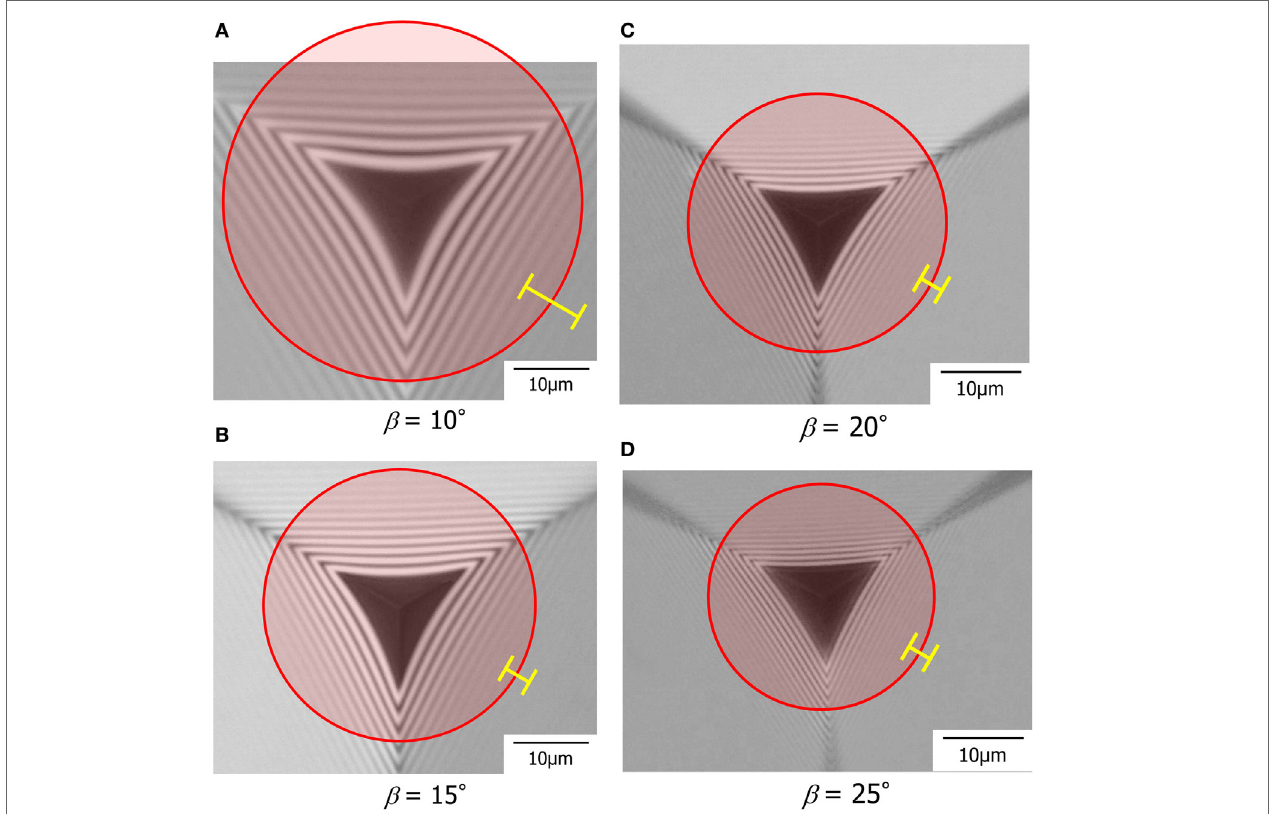
FigUre 7 | Top views of contact regions of soda-lime glass under different indenters at a load of 0.5 n . The face angles of indenters are (a) 10°, (B) 15°, (c) 20°, and (D) 25°. The regions enclosed by circles represent the sinking-in region. Error bars denote ± 1 SD of diameter of sinking-in region.